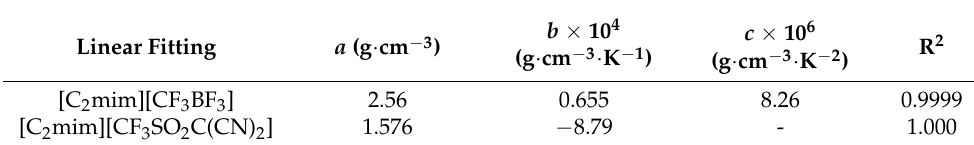
Table 1. Fitted parameters for the temperature dependence of density for [C 2 mim][CF 3 BF 3 ] and [C 2 mim][CF 3 SO 2 C(CN) 2